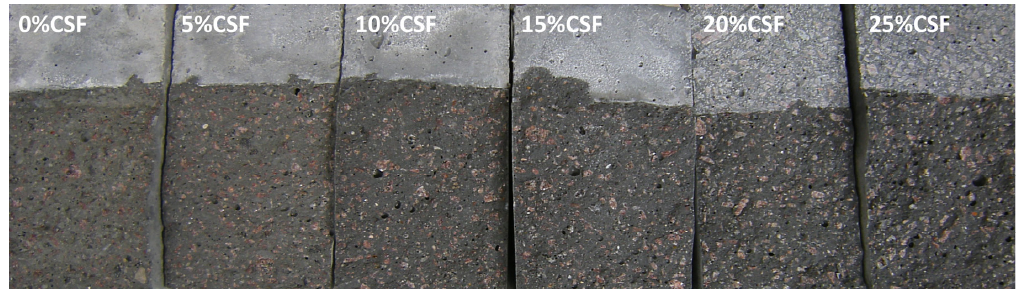
Figure 11. Split cross-sections of notched HPC beam specimens.